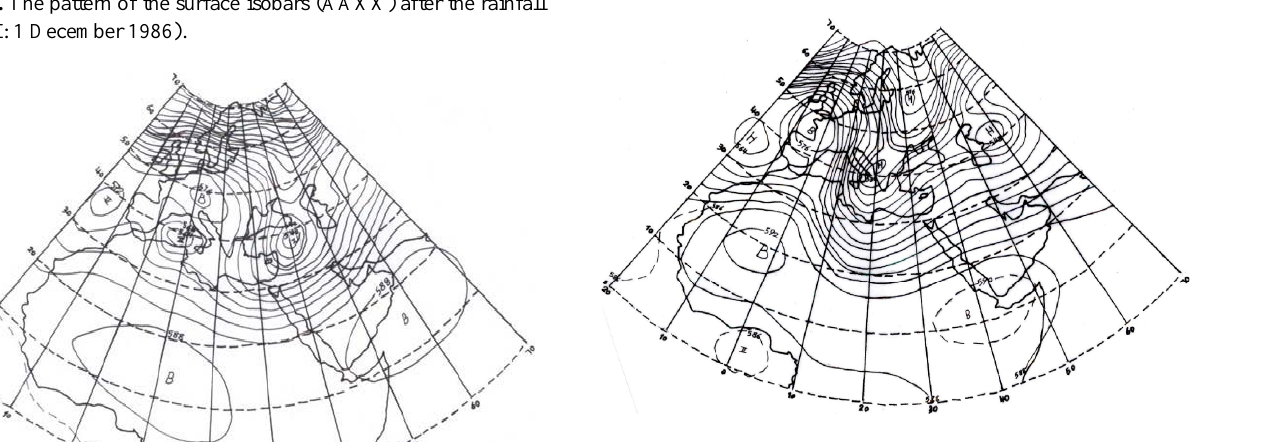
Fig. 5 The pattern of the geopotential heights at 500 hPa after the rainfall (Type I: 1 December 1986)